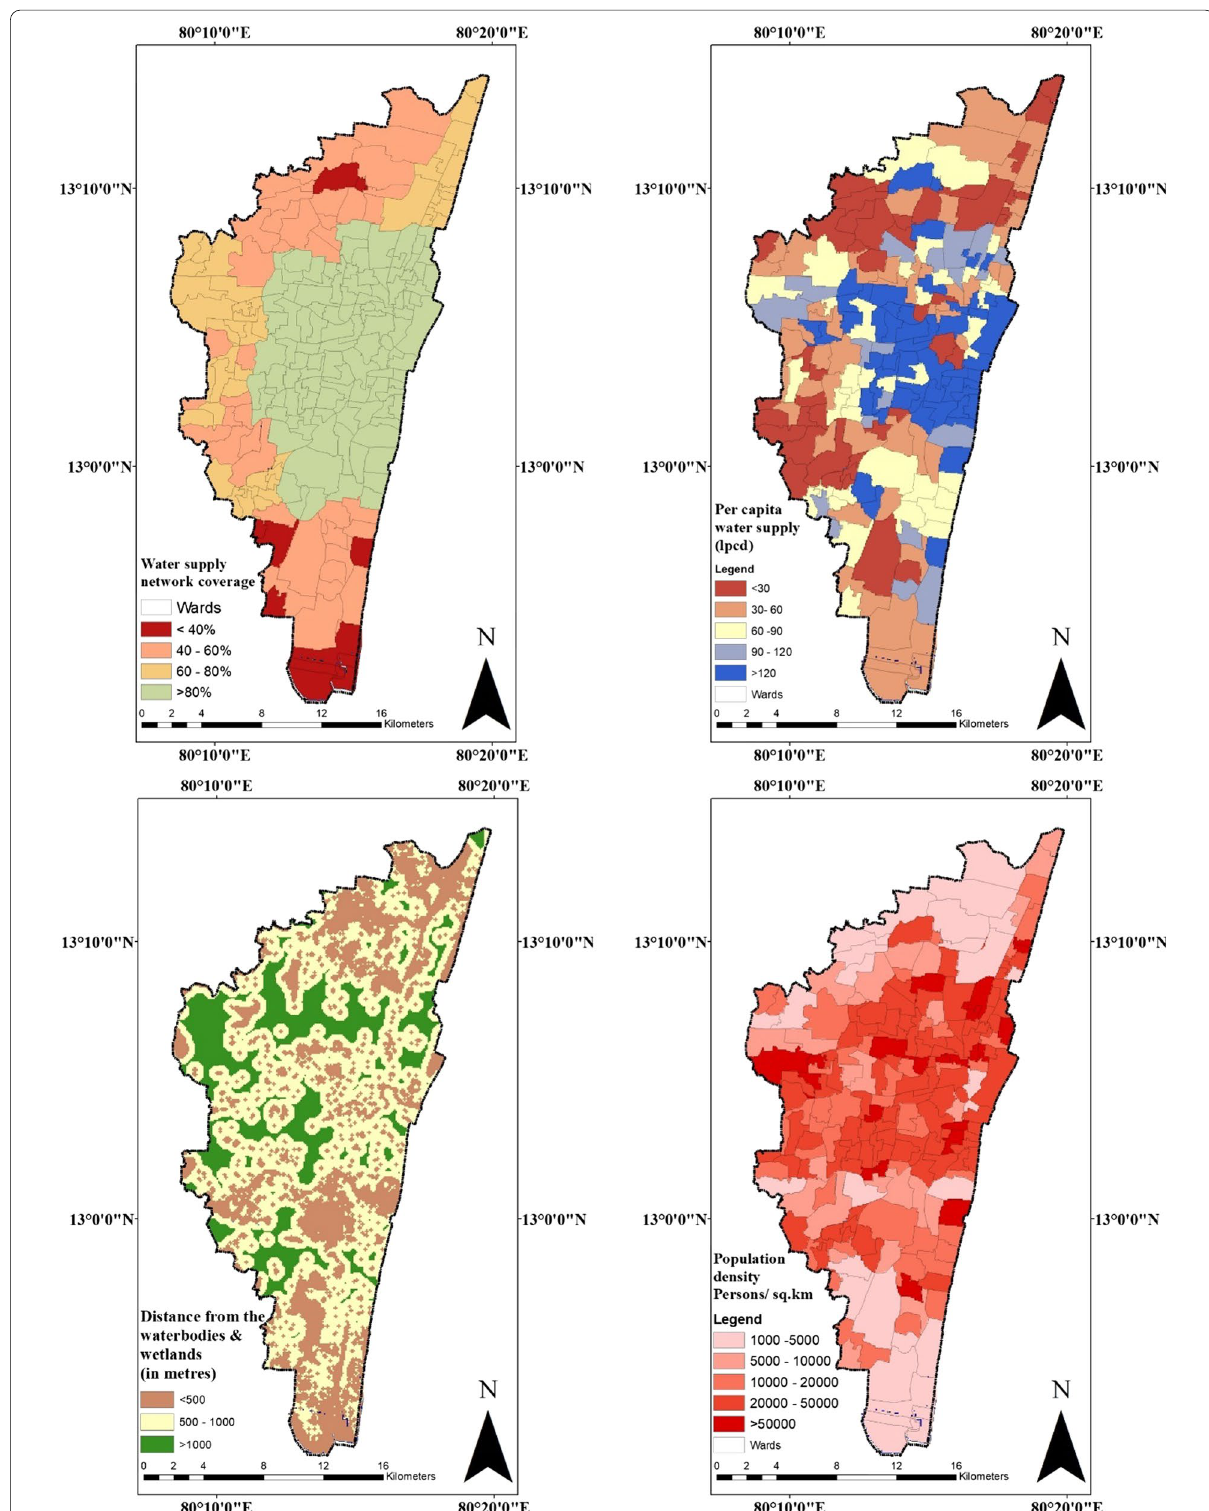
Fig. 5 Water supply network coverage, per capita water supply, distance to waterbodies and wetlands and population density